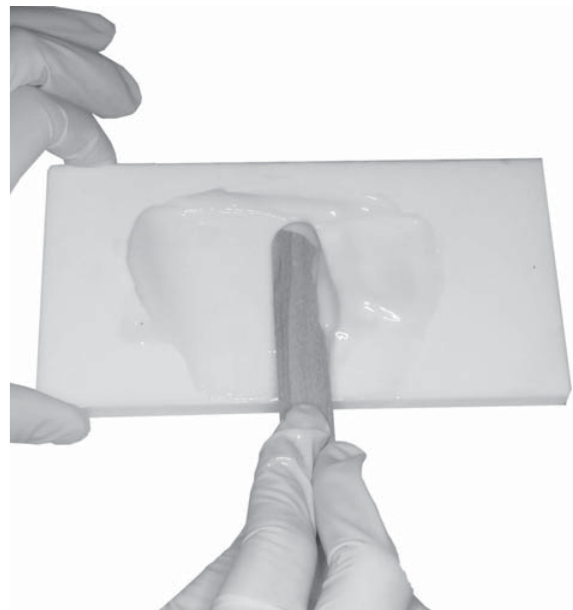
Figure 2- Homogeneous paste of castor oil polyurethane (COP) obtained after manual mixing and mixing with